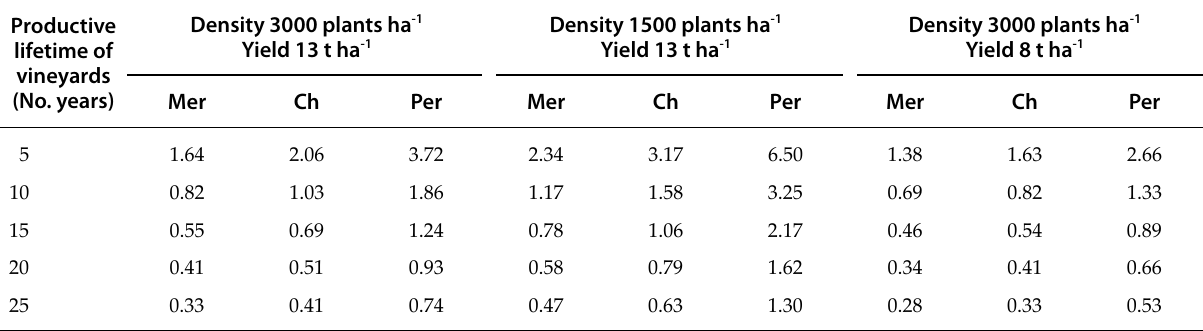
Table 2. Average annual costs of replacement “RC N ” (€/year/plant) estimated for three grapevine cultivars in relation to productive lifetime of vineyards, density of plants per hectare and yield per hectare. N = 1 is the planting year. Mer = ‘Merlot’; Ch = ‘Chardonnay’; Per =